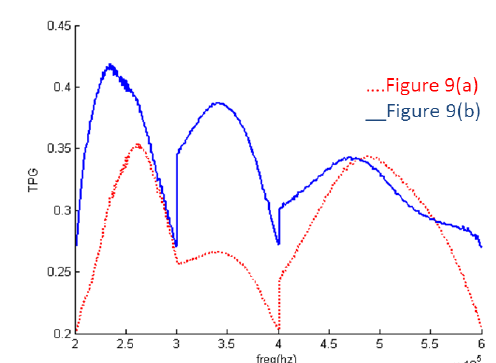
Figure 10. TPG of the EIMNs in Figure